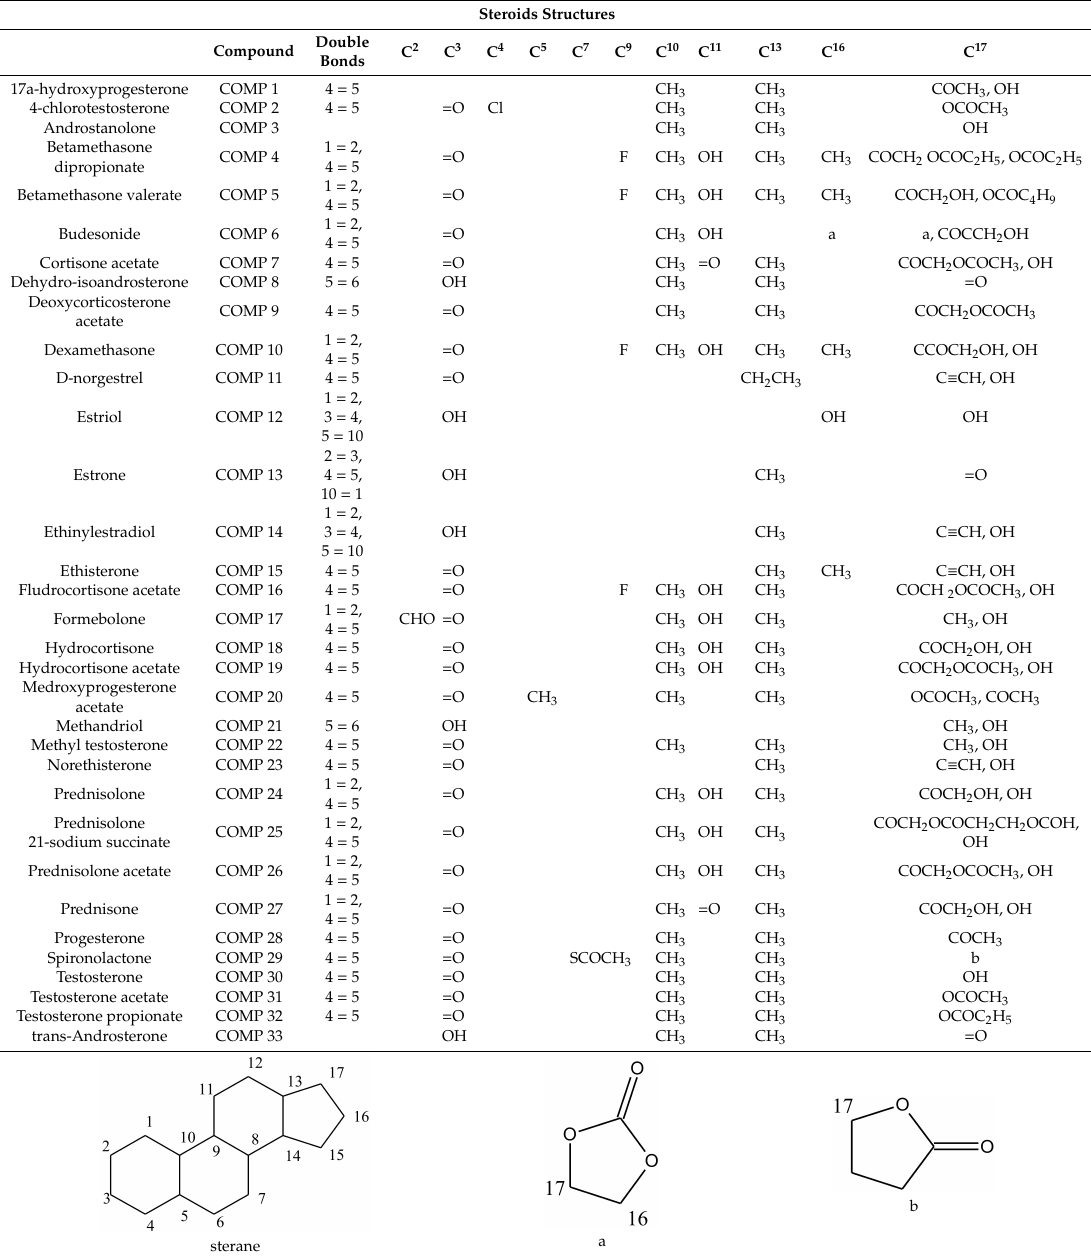
Table 4. Structures of studied